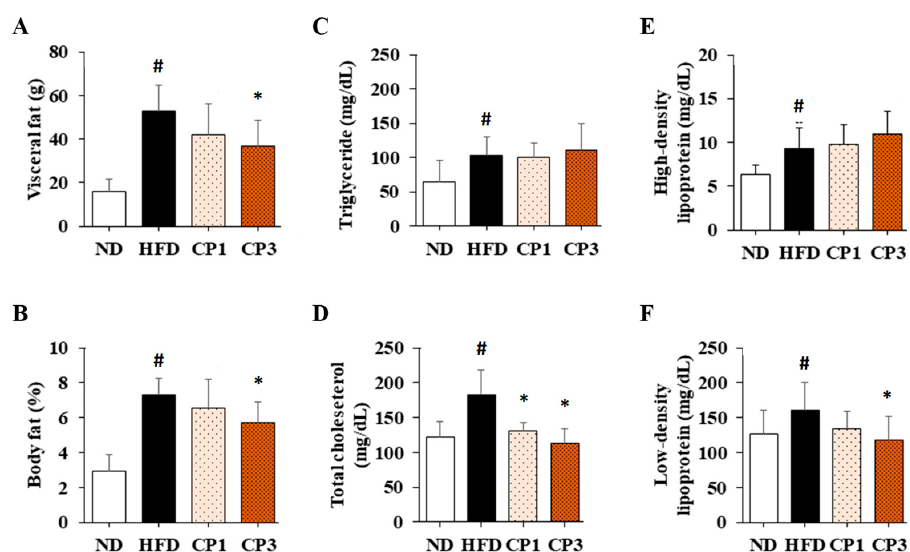
Figure 3. The average ( A ) visceral adipose weight, ( B ) body fat percentage and serum levels of ( C ) triglyceride, ( D ) total cholesterol, ( E ) high-density lipoprotein and ( F ) low-density lipoprotein of rats. After 16-week treatment, the rats were sacrificed, and the visceral fat was isolated and weighed to calculate body fat percentage. Moreover, the blood samples were harvested to measure serum levels of triglyceride, total cholesterol, high-density lipoprotein and low-density lipoprotein as described in the Materials and Methods section. Results are expressed as mean ± S.D. for each group of rats ( n = 6). # p < 0.05 compared with the ND group; * p < 0.05 compared with the HFD group.